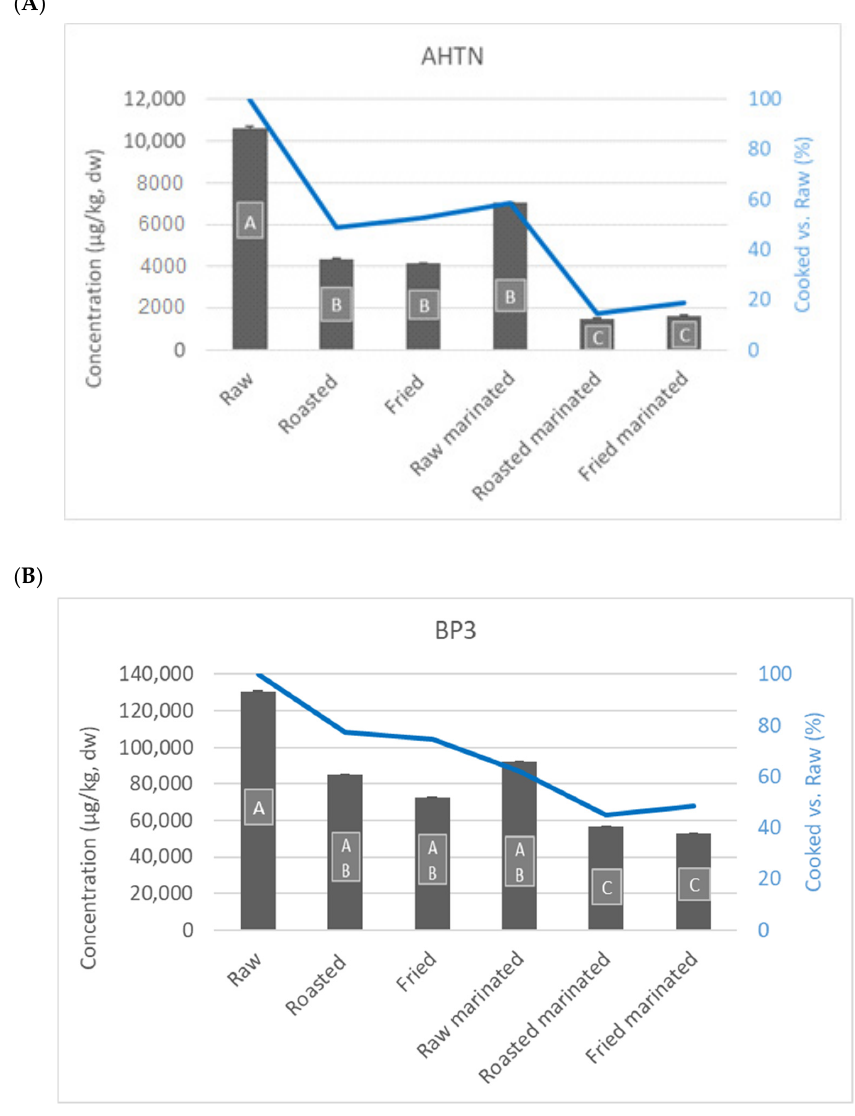
Figure 1. Impact of domestic cooking on AHTN ( A ) and BP3 ( B ) levels in European seabass ( Dicen- trarchus labrax ). Different letters in each column show statistically significant differences ( p < 0.05) from the given mean. Means were compared by Tukey HSD test or Dunnet’s T3 test, respectively, depending on whether or not homogeneity of variances was confirmed by Leven’s